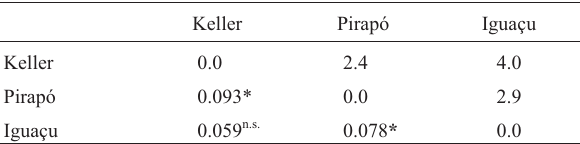
TableIV -Matrixoffixationindexes F st (lower-left)andofnumberofmi- grants per generation Nm (upper-right) among three populations of Astyanax altiparanae from the Keller, Pirapó and Iguaçu rivers, based on RAPD markers.